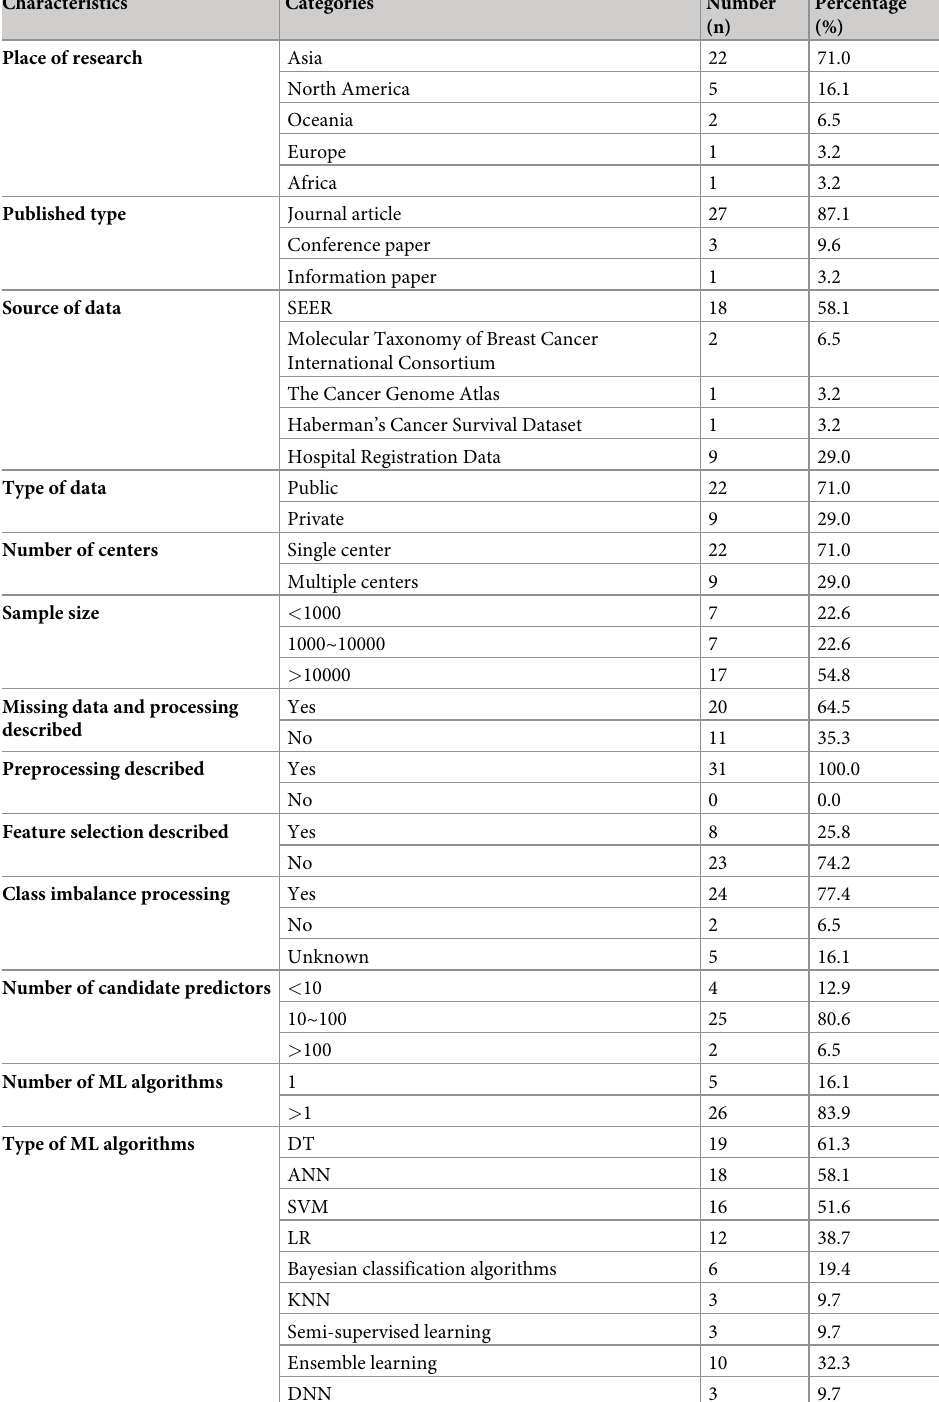
Table 3. Primary characteristics and categories of the 31